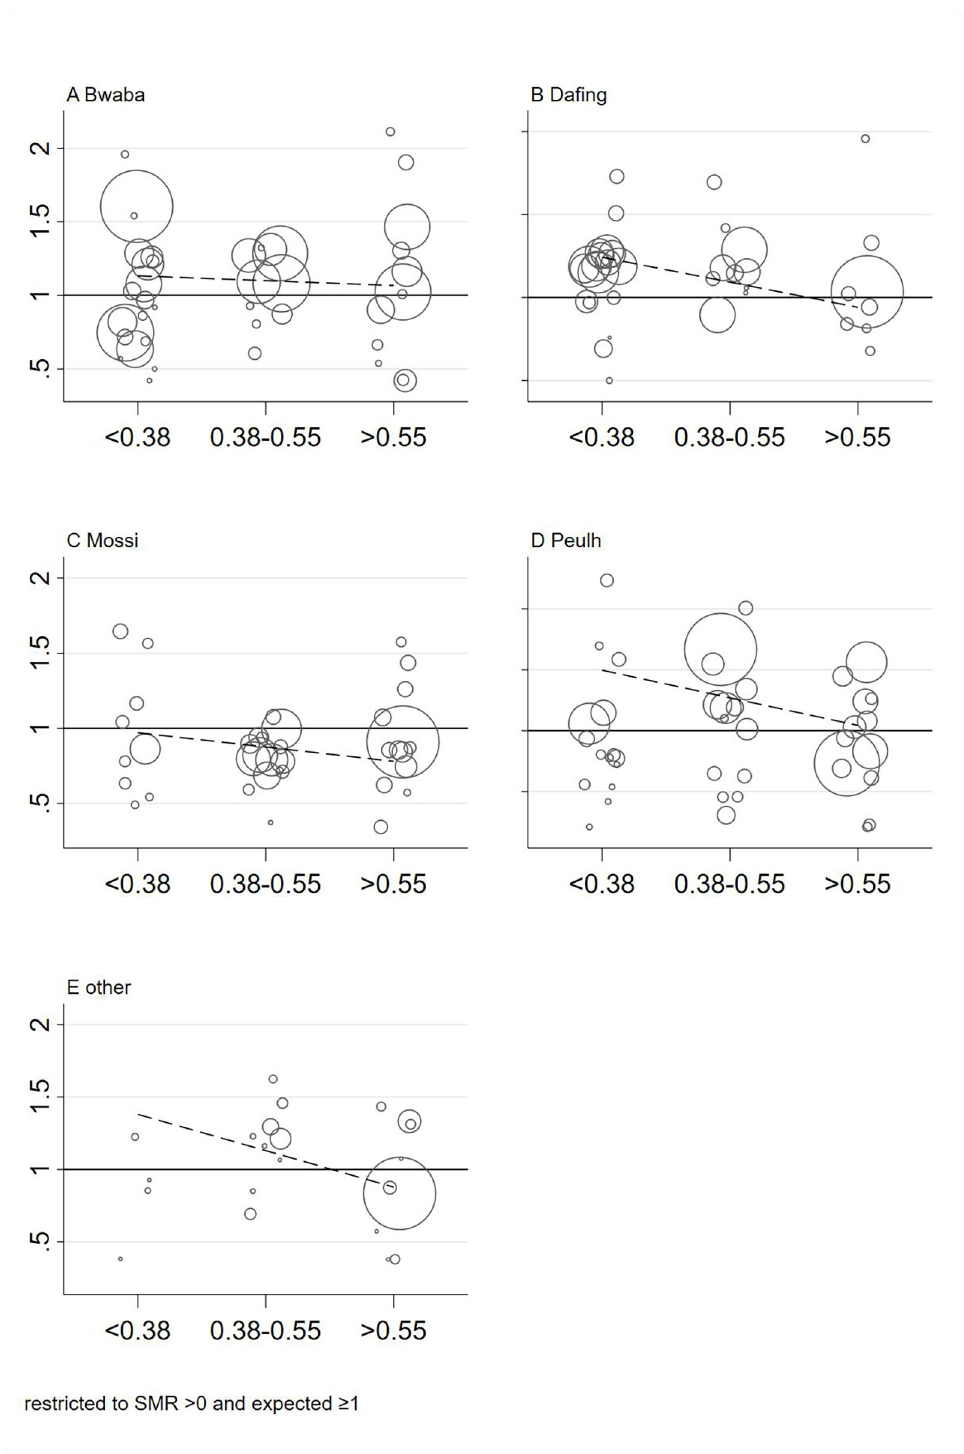
Fig 2. Standardized mortality ratios of each village by ethnic diversity separated for ethnic groups. SMRs are calculated in comparison to the entire HDSS, the bubble size indicates the number of observed deaths; dashed lines indicate linear trends (weighted by the number of observed